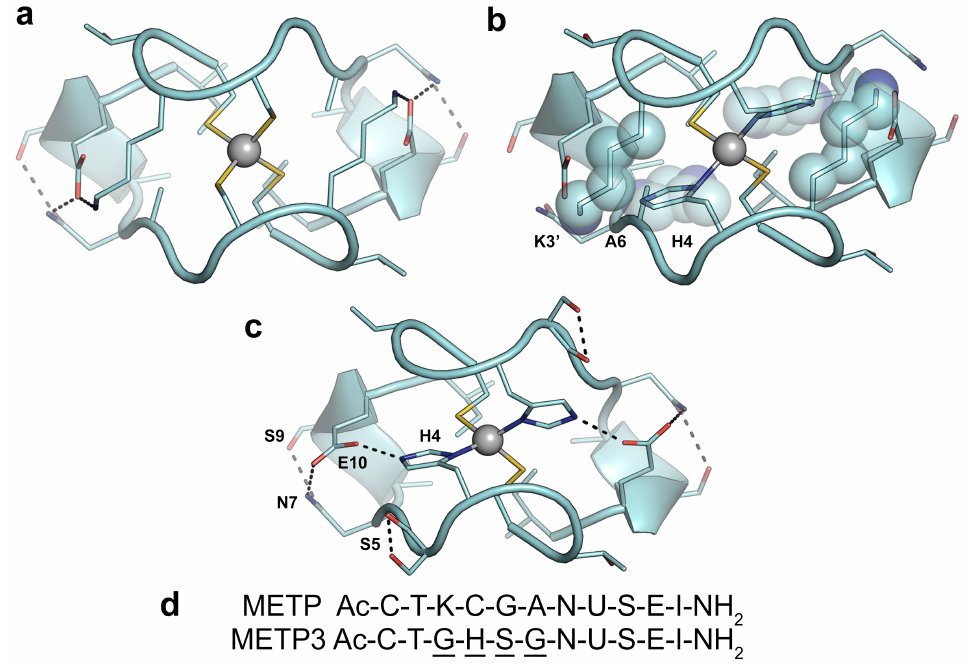
Figure 1. Redesign of the Cys 4 METP binding site into Cys 2 His 2 . ( a ) Energy minimized structure of Zn(II)-METP complex. The coordinating and hydrogen bonded residues are shown as sticks. ( b ) Cys 2 His 2 Zn(II)-binding site housed in the unoptimized Zn(II)-METP model structure. The steric clashes of His 4 with Lys 3’ and Ala 6 side chains are evidenced as spheres. ( c ) Energy-minimized model of Zn(II)-METP3 complex. In all the panels, the Zn(II) ion is reported as a gray sphere. Peptide backbone is represented as a ribbon. ( d ) Comparison of the monomeric peptide sequence of METP and METP3. U represents 2-aminoisobutyric acid (Aib).